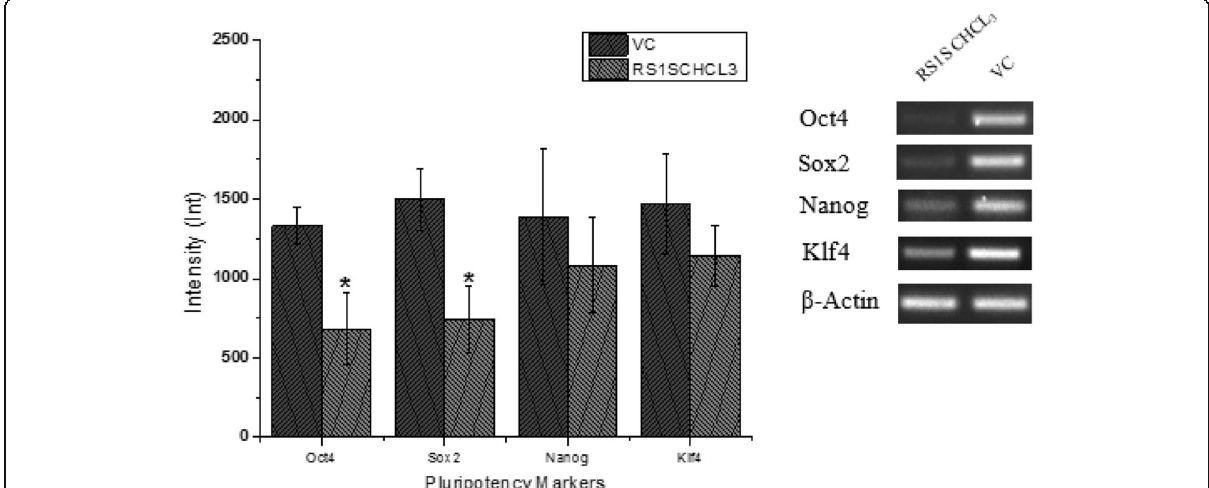
Fig. 8 RT-PCR analysis of stem cell genes in NT2 cells after treatment for 14 days with RS1S CHCL3 extract (5 μ g/ml). Representative agarose gel electrophoresis patterns of RT-PCR products showed reduced expression of Oct4 and Sox2. All gene expression data were normalized to β -actin as an internal control. Band intensity was measured and the values were expressed as the mean ± SD of two independent experiments. * P < 0.05 compared to vehicle control (VC; 0.001% MeOH)